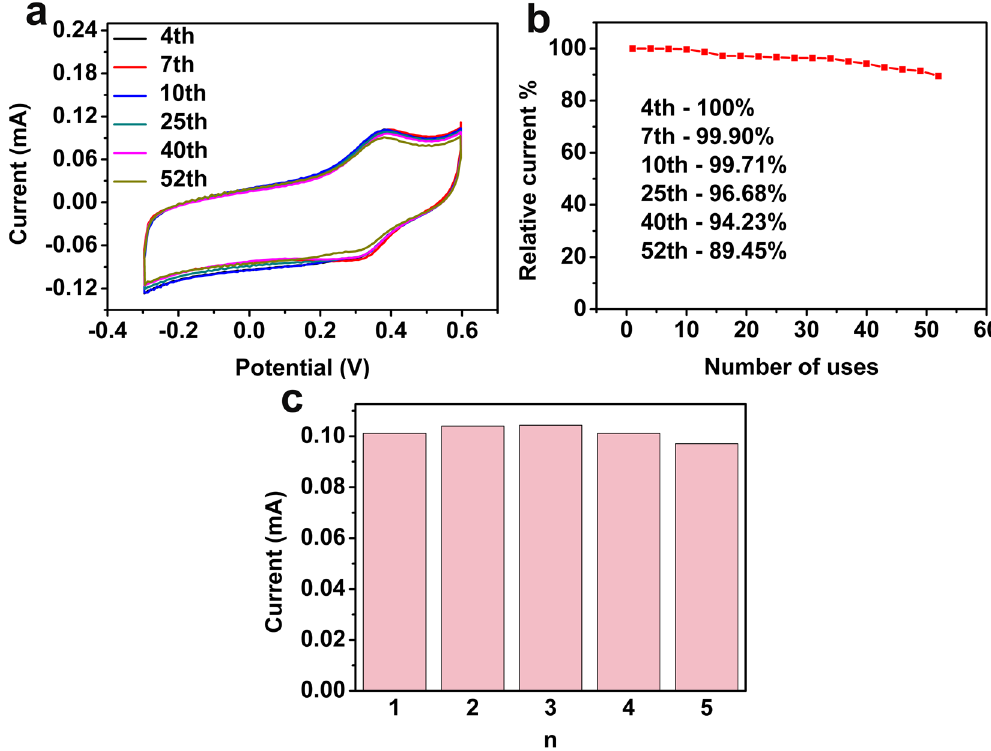
Figure 6. Stability and reproducibility of the Pd/NPG wire biosensor. ( a ) Response currents of the Pd/ NPG wire biosensor under different measurements. ( b ) Stability study of the Pd/NPG wire biosensor. ( c ) Reproducibility study on Pd/NPG wire biosensor.